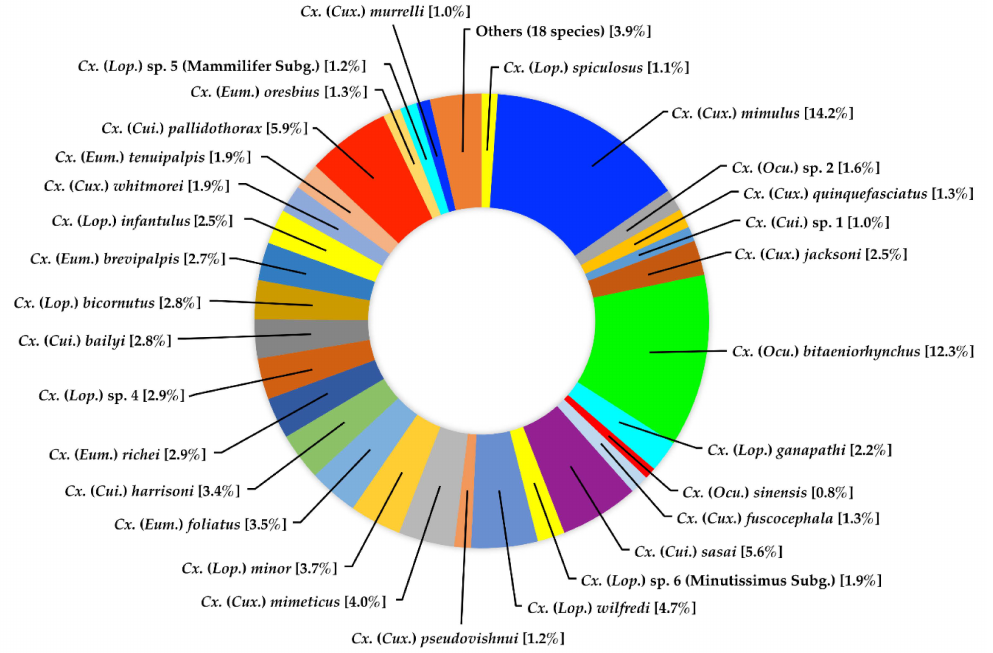
Figure 3. Species composition and abundance of mosquitoes of the genus Culex collected in Doi Inthanon National